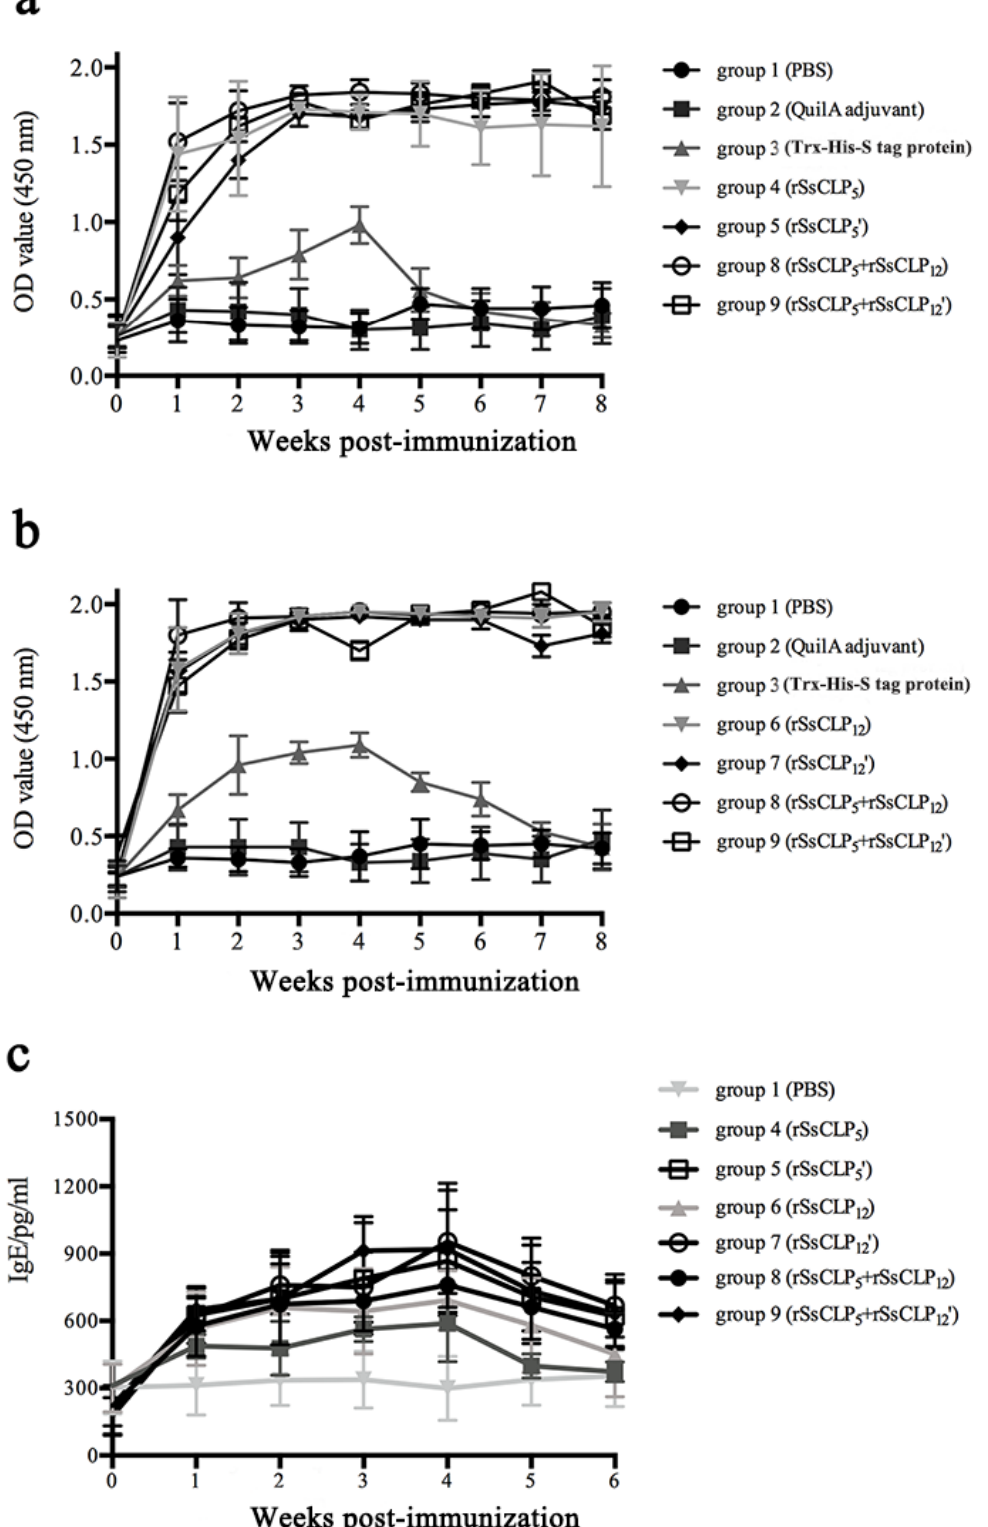
Figure 4. Variation of specific IgG ( a and b ) and total IgE ( c ) levels in the sera of immunized rabbits. a: the OD 450 nm value of the specific IgG antibodies was detected by an rSsCLP5-based indirect ELISA; b: the OD 450 nm value of specific IgG antibodies was detected by an rSsCLP12-based indirect ELISA; c: the total IgE antibody concentration (pg / mL) was detected by an ELISA kit (Elabscience, Wuhan, China). The rSsCLP 5 and rSsCLP 12 refer to rSsCLP5 and rSsCLP12,